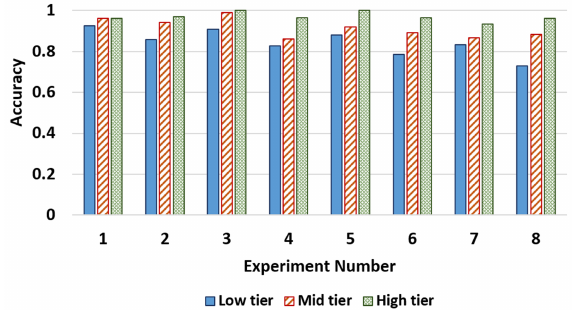
Figure 12. Model accuracies of each experiment.